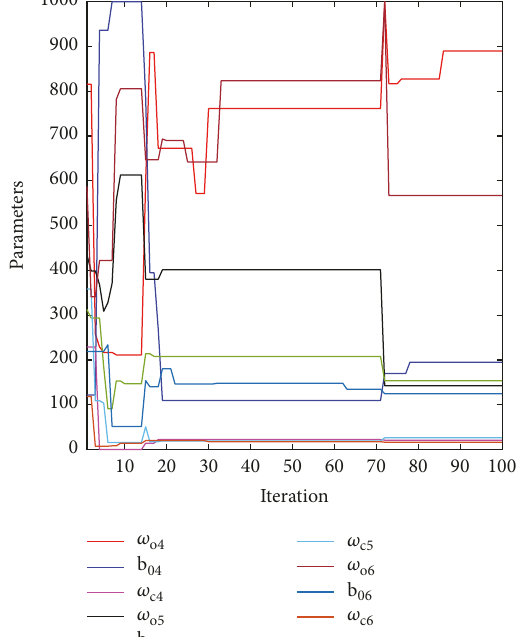
Figure 6: Tuned parameters of outer loop controller.